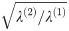
The components of the second eigenvector.We multiply the second eigenvector components by the ratio of strength of the corresponding mode-signals, λ(2)/λ(1), reflecting the fact that the contribution of the n-th eigenmode to the time series is proportional to λ(n). For the entire period, the currency markets are distributed to the left of the origin, mainly close to the negative real axis, while equity markets are along the positive real axis and also in the first quadrant, indicating negative equal-time correlation between the equity and foreign exchange markets. Again, these features are almost the same for Period 3, the severe crisis period, and differ in other periods.